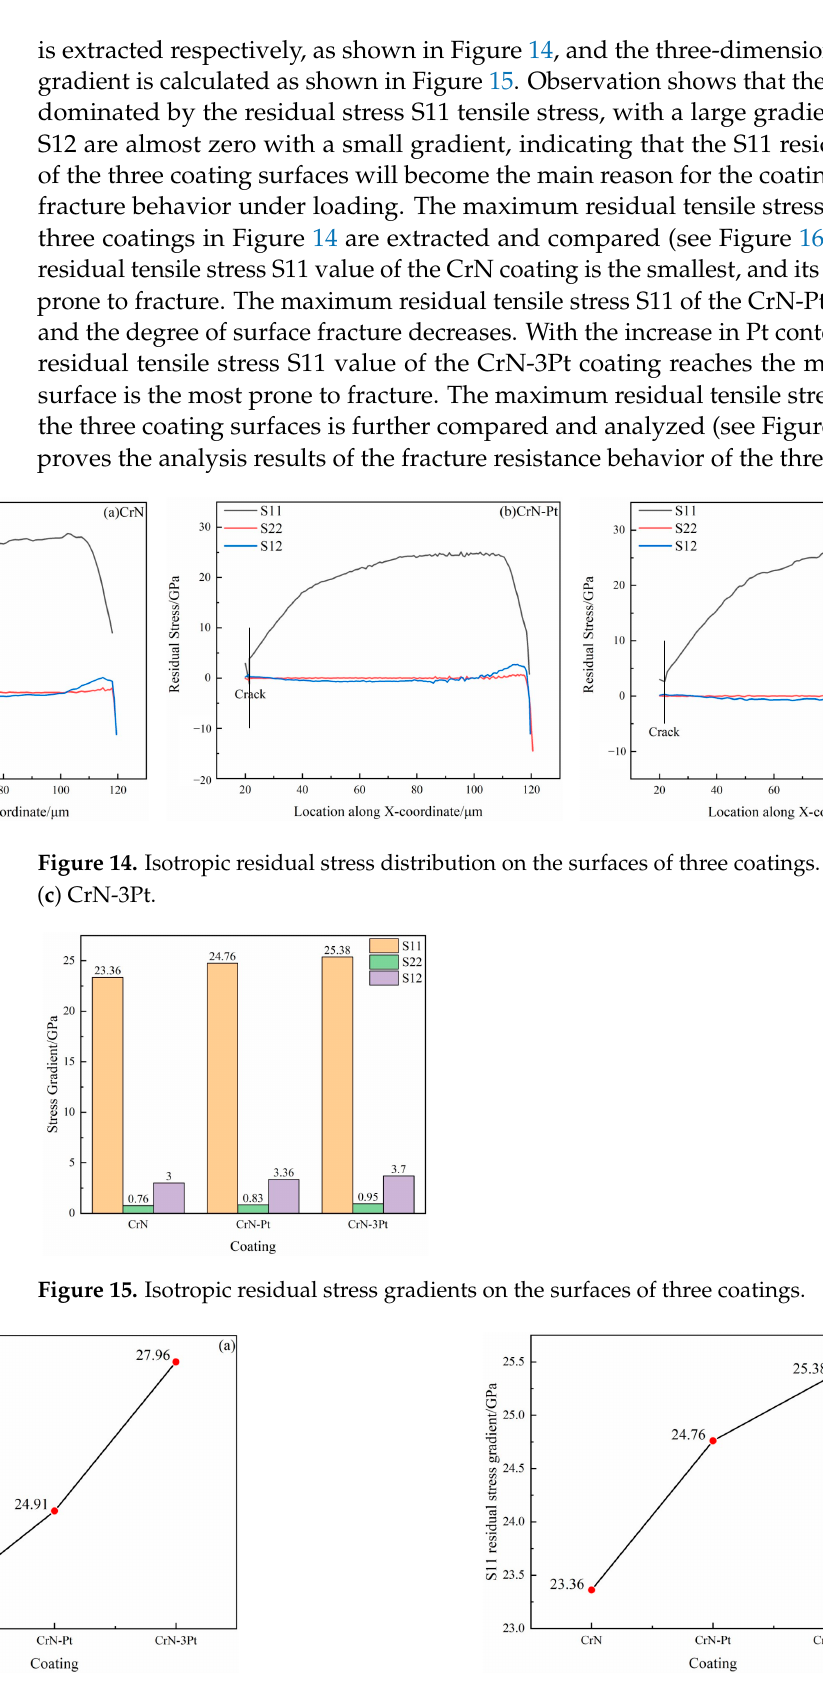
Figure 16. Comparison of the maximum value and gradient of the maximum residual tensile stress S11 on the surfaces of the three coatings. ( a ) S11 residual stress; ( b ) S11 residual stress gradient.